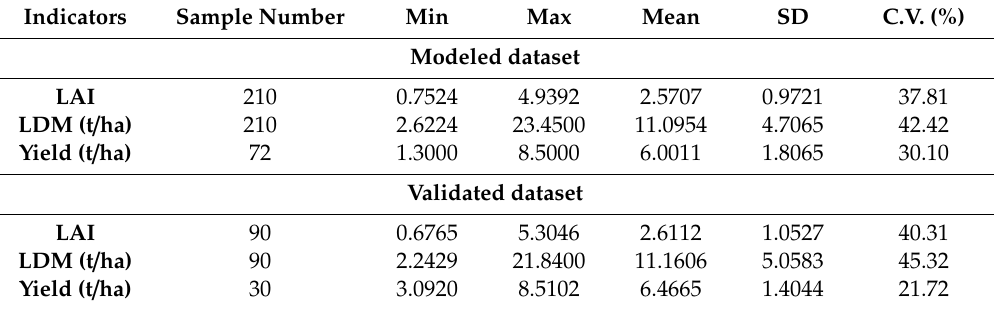
Table 3. Descriptive statistics of wheat leaf area index (LAI), leaf dry matter (LDM), and yield of di ff erent cultivars and nitrogen